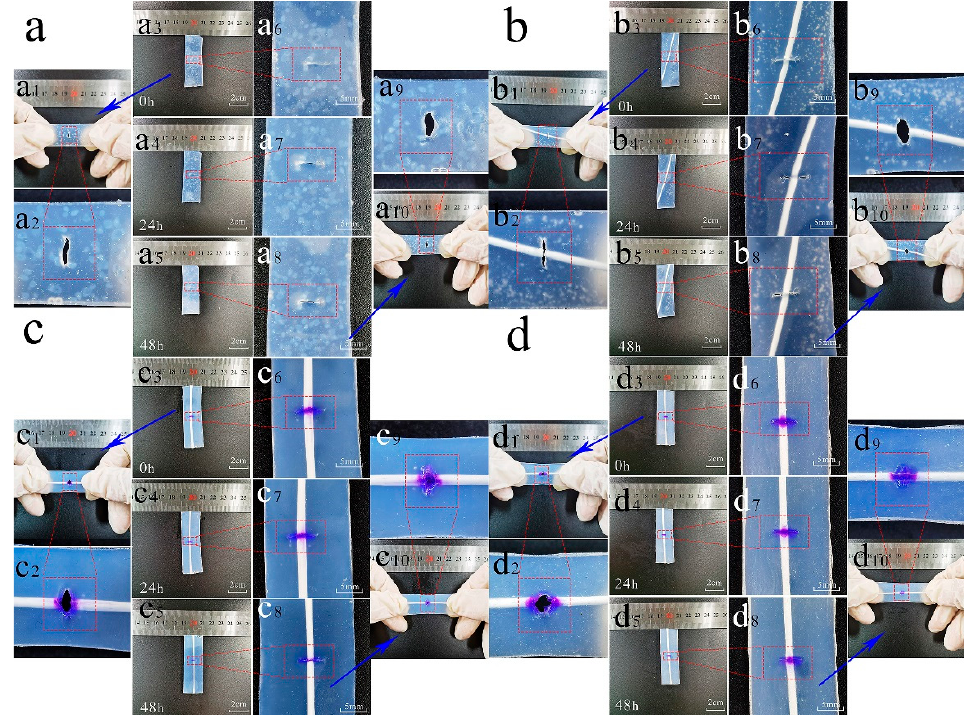
Figure 8. Optical images showing the self-healing process of wound in different conditions within 48 h. ( a ) Self-healing effects of matrix. A 5 mm wound in the center of the matrix, left stationary at 37 °C for 48 h and observed every 12 h (( a , d ) as well). ( a1 – a10 ) Optical images of self-healing effects of the matrix every 12 h. ( b ) Self-healing effects of artificial skin (bionic microvascular without healing agent). ( b1 – b10 ) Optical images of self-healing effects of matrix every 12 h. ( c ) Self-healing effects of artificial skin. A 5 mm wound in the center of the matrix, left stationary at 25 °C for 48 h and observed every 12 h. ( c1 – c10 ) Optical images of self-healing effects of the matrix every 12 h. ( d ) Self-healing effects of artificial skin. ( d1 – d10 ) Optical images of self-healing effects of the matrix every 12 h.